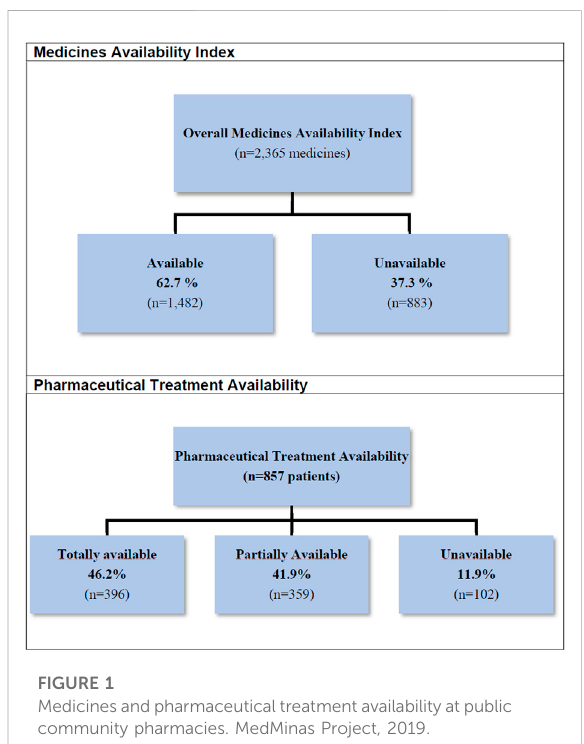
FIGURE 1 Medicines and pharmaceutical treatment availability at public community pharmacies. MedMinas Project,